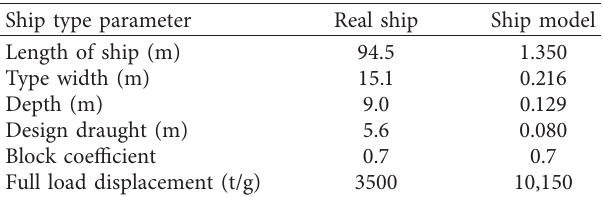
Table 1: Ship type parameters.